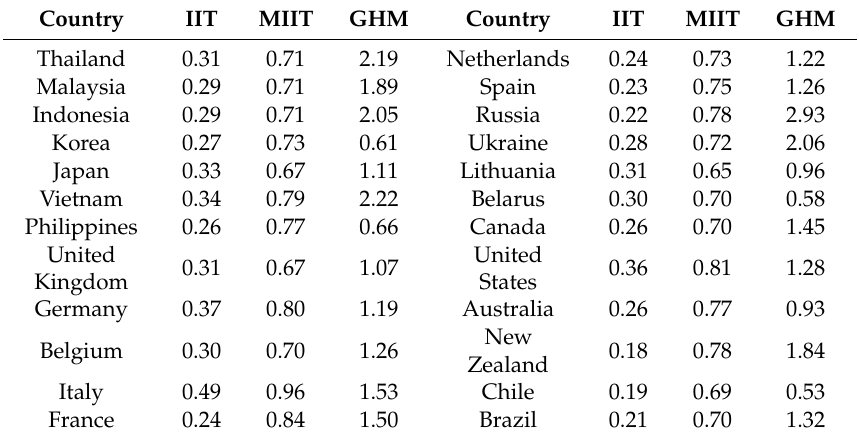
Table 3. Annual average intra-industry trade index of forest products between China and the 24 countries from 2000 to 2014.